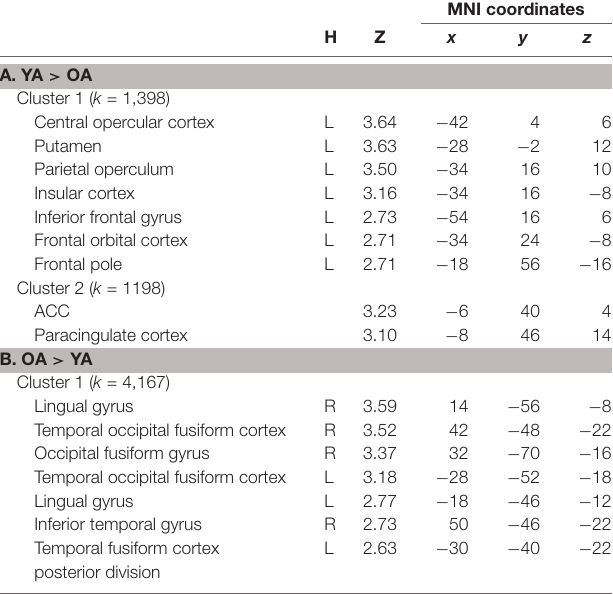
TABLE 1 | Brain regions within significant clusters on the LC seed-based whole-brain connectivity analysis between younger adults (YA) and older adults